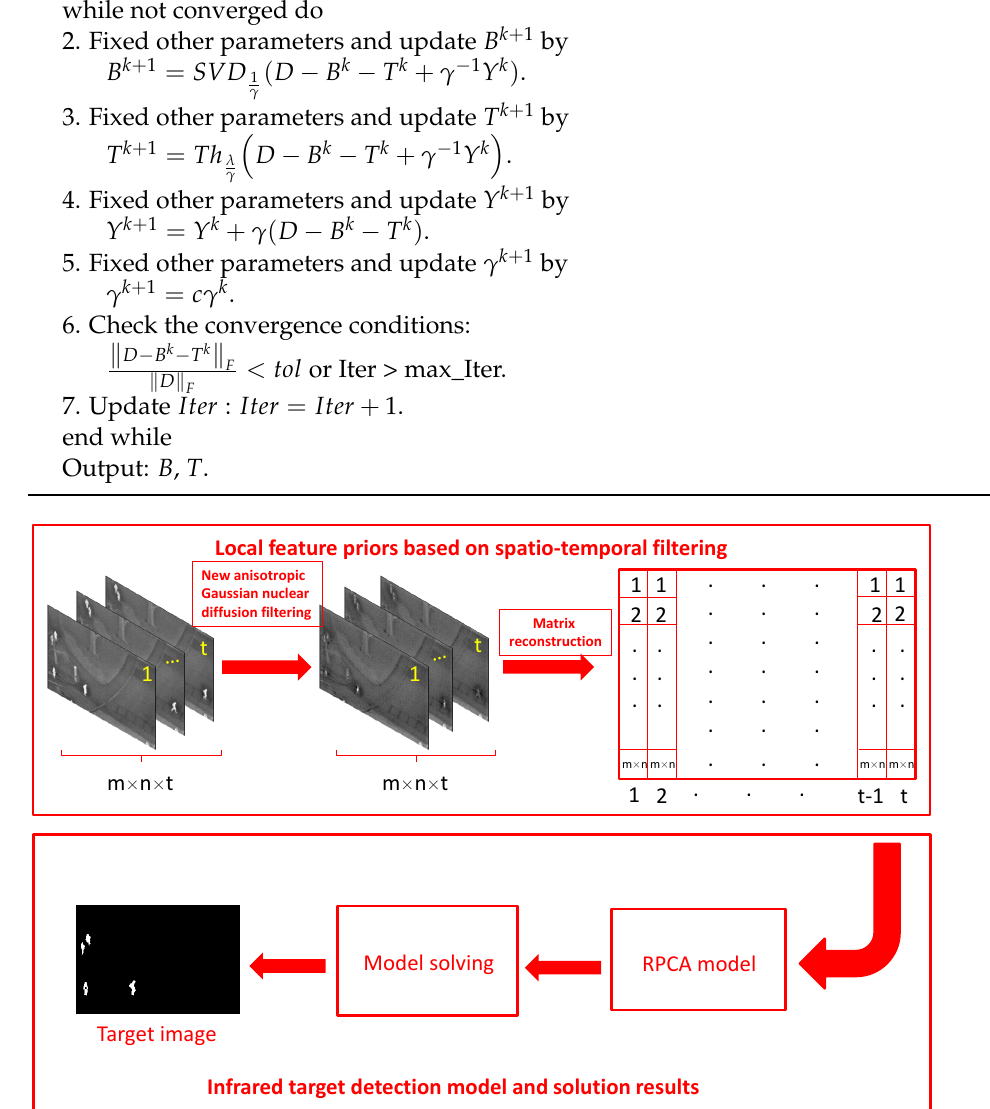
Figure 3. The flow chart of the proposed